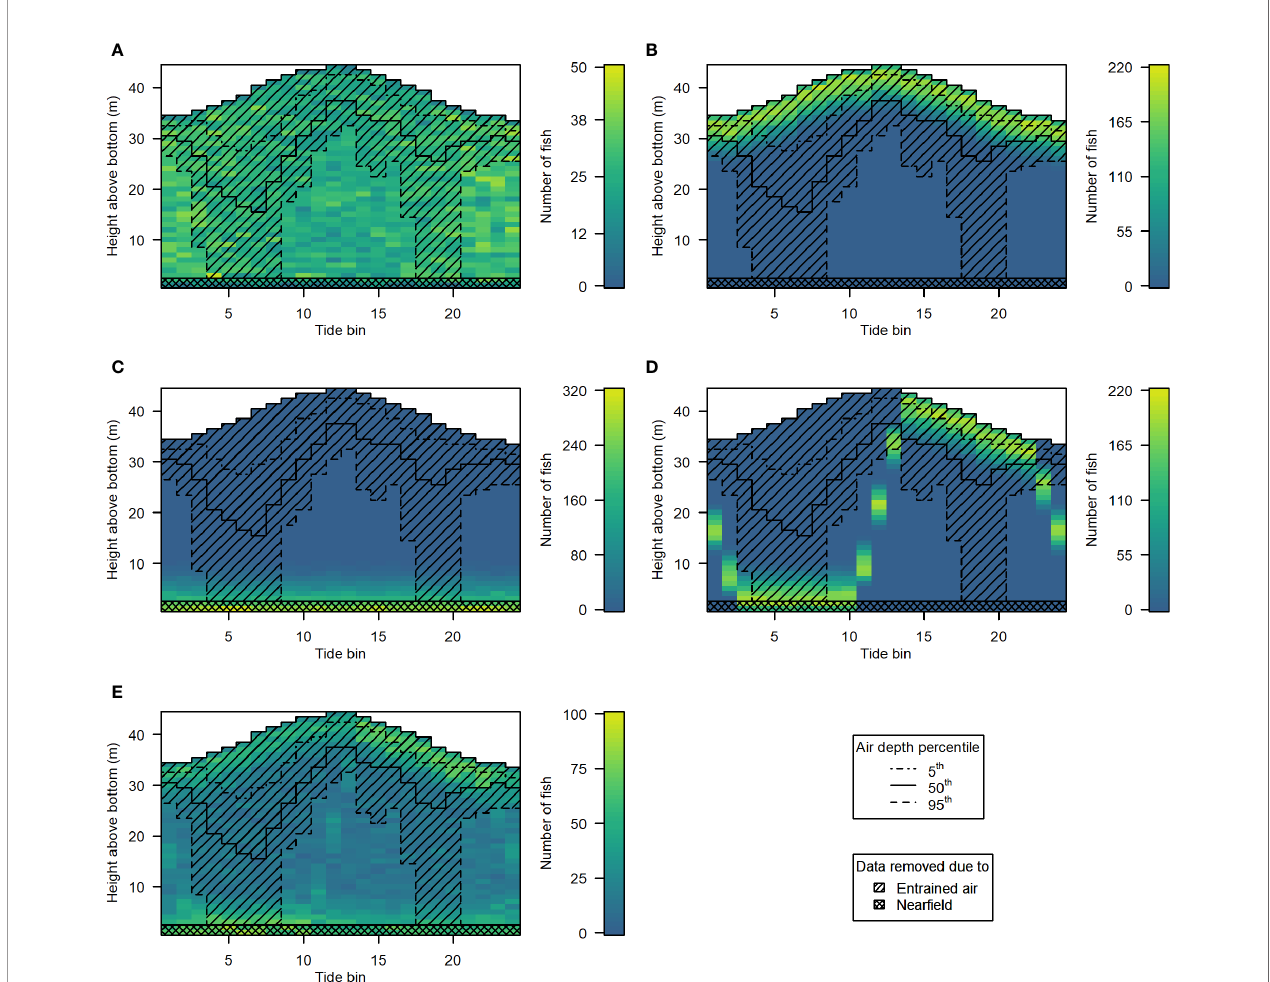
FIGURE 10 | Hypothetical fi sh distributions generated for scenarios 1 to 5 [ (A-E) , respectively]. Color indicates the number of fi sh in each depth bin. Datapoints excluded by the 5 th (dot-dash line), 50 th (solid line), and 95 th (dashed line) percentile depth of the entrained air layer are indicated by the hatched area. The crosshatched rectangle covering the lowermost 2 m of the water column indicates the data that would be omitted due to the height of the acoustic near fi eld above the sea fl